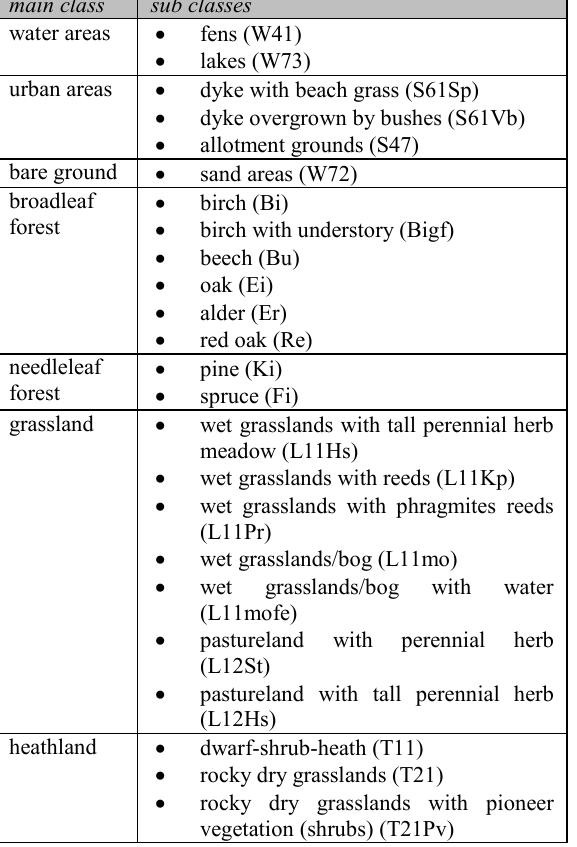
Table 3. Overview of the classes